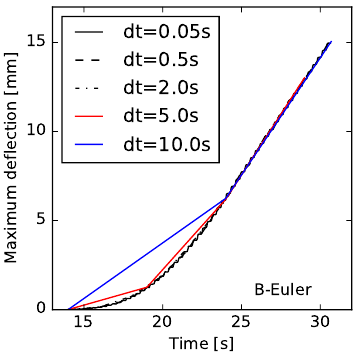
Figure 7. Numerical response of backward Euler method for different time